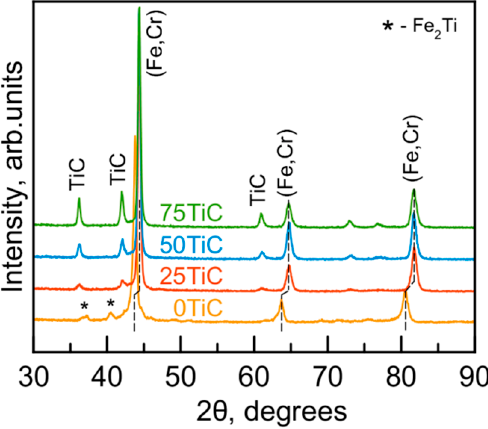
Figure 4. XRD patterns of the coatings.